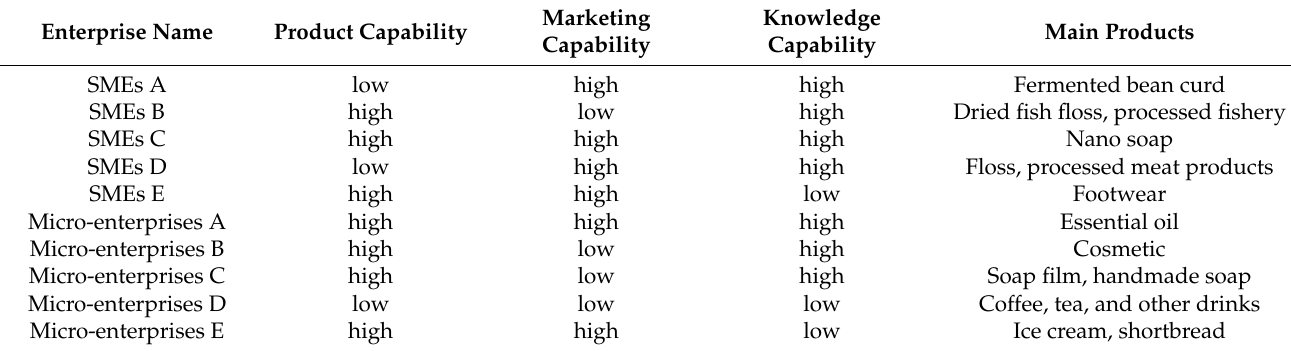
Table 3. Summary of SMEs and micro-enterprises’